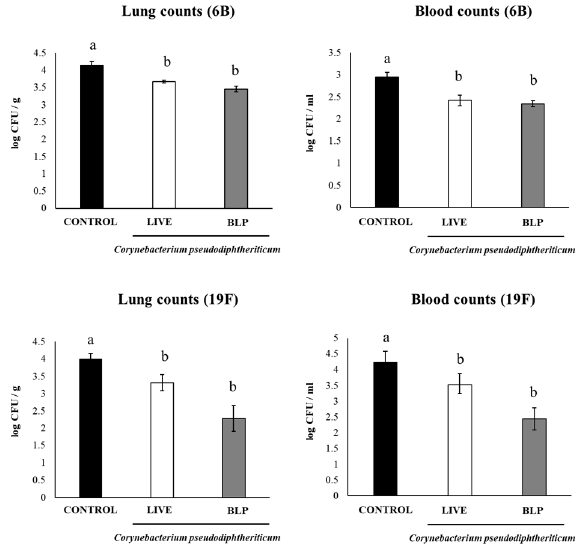
Figure 4. Resistance to Streptococcus pneumoniae infection induced by the immunization with the pneumococcal conjugate vaccine (PCV) plus Corynebacterium pseudodiphtheriticum 090104 or its bacterium-like particles (BLPs) in infant mice. Swiss albino infant mice (3 weeks old) were immunized by the nasal route with PCV or PCV plus C. pseudodiphtheriticum 090104 or it BLPs on days 0, 14, and 28. Five days after the last immunization (day 33), mice were nasally challenge with S. pneumoniae serotypes 6B or 19F. Lung and blood pneumococcal cell counts were performed on day 2 post-infection. Results represent data from three independent experiments ( n = 12) and are expressed as mean ± standard deviation. Letters indicate significant differences between the groups ( p < 0.05).